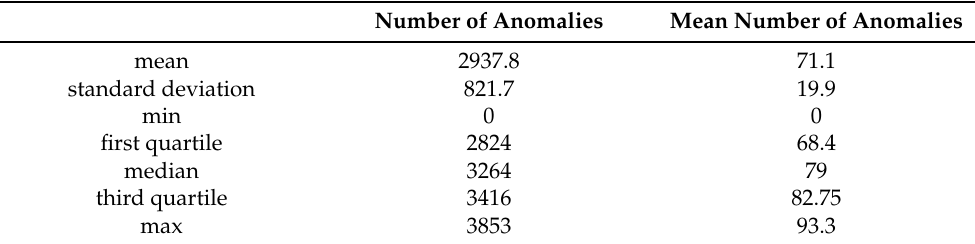
Table 2. Descriptive statistics considering the number of anomalies per sensor using the flow-speed correlation analysis.